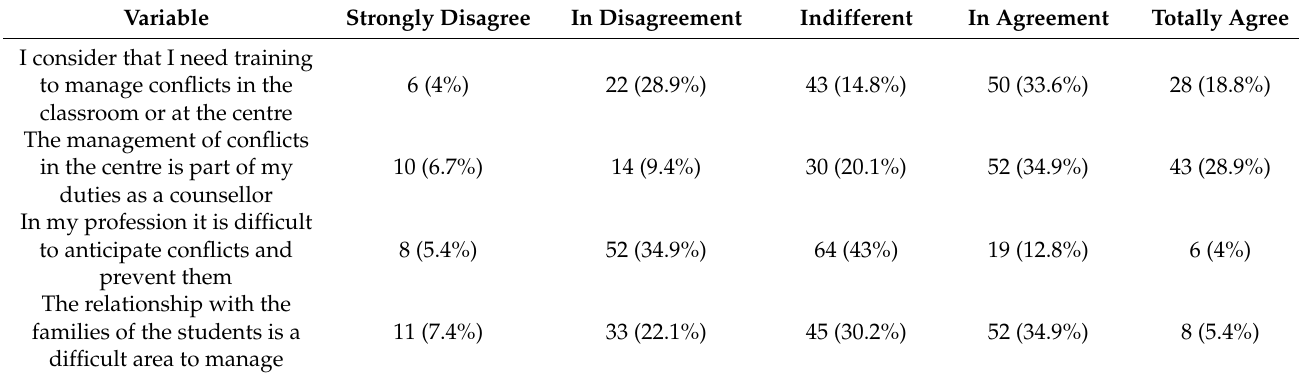
Table 2. Descriptive results of the scale variables.